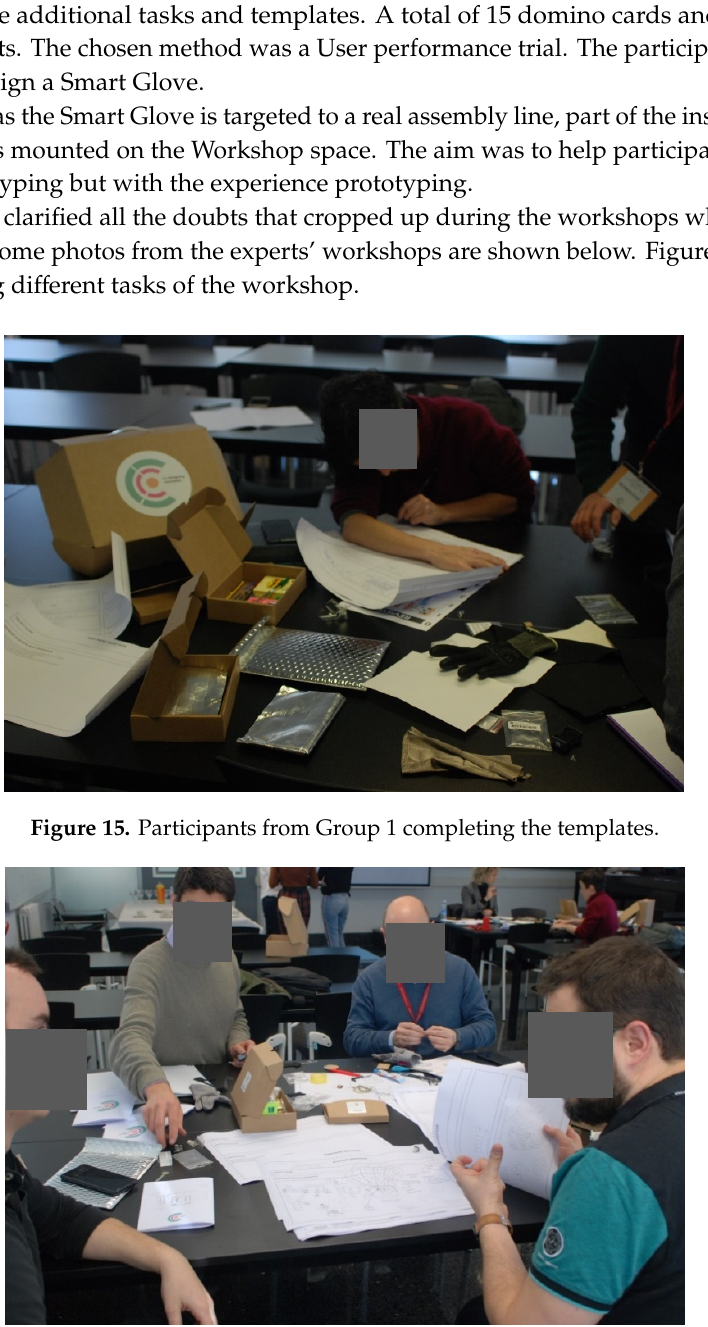
Figure 17. Participants from Group 1 making the physical prototype. Figure 18. Participants from Group 2 making the physical prototype.